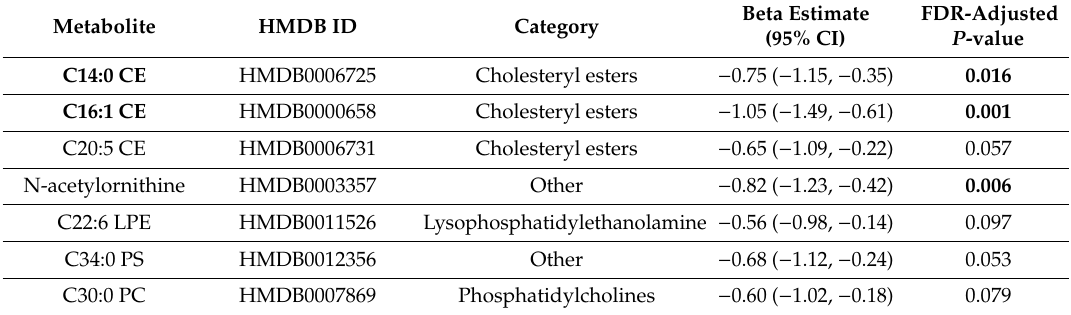
Table 5. Metabolite discovery among normal weight women ( n = 630) 1,2,3 .